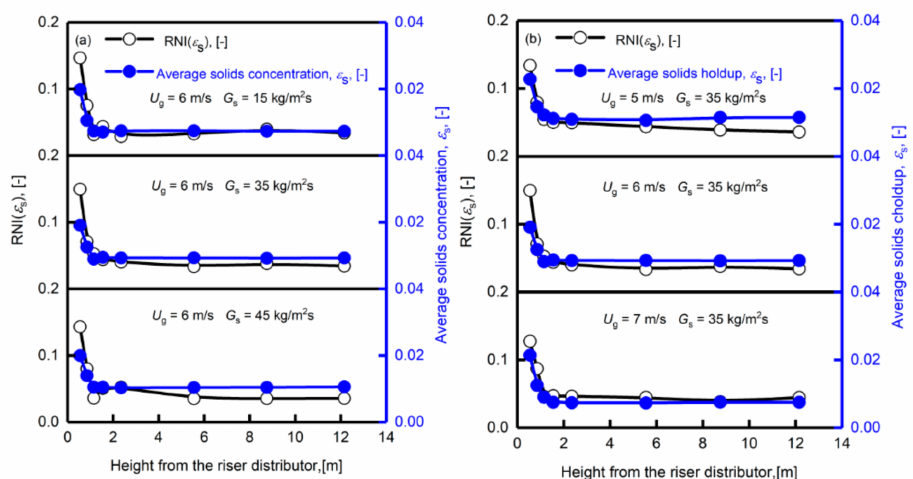
Figure 9. Axial distributions of the solids holdup and RNI ( ε s ). (( a ) represents the distribution of RNI under different solids circulation rates. ( b ) represents the distribution of RNI under different superficial gas velocities).